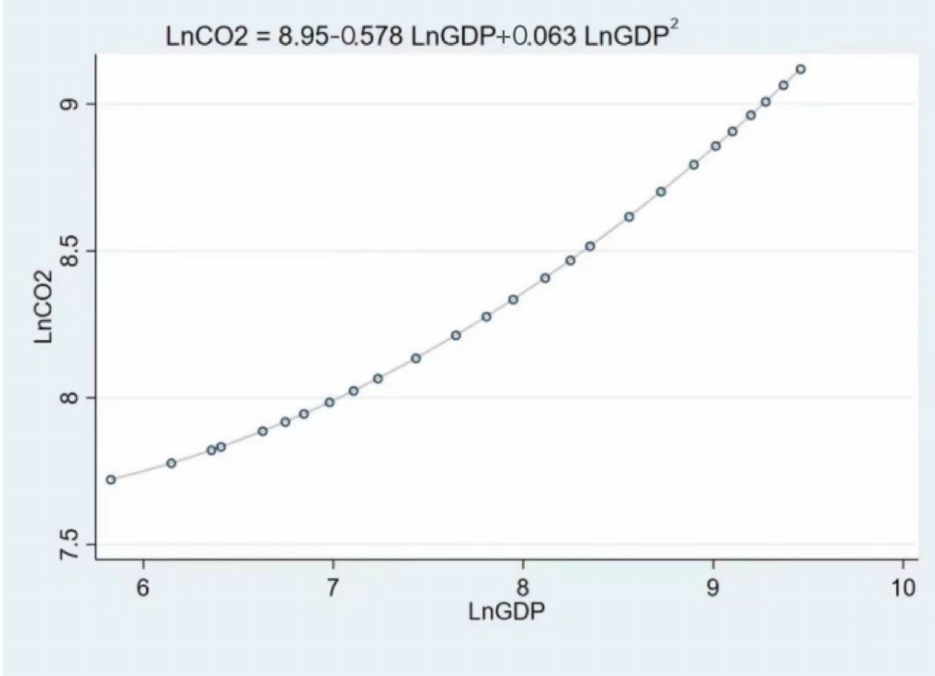
Figure 8. Equation (5).